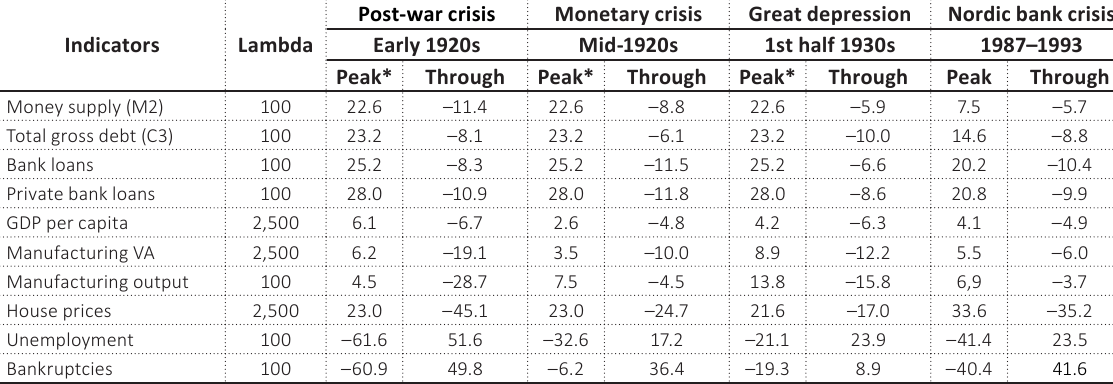
Table 1. Cycle values of financial and key macroeconomic variables as percentages connected to financial crises